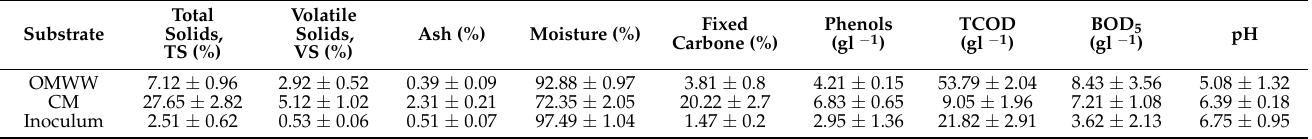
Table 2. The OMWW, CM, and the inoculum